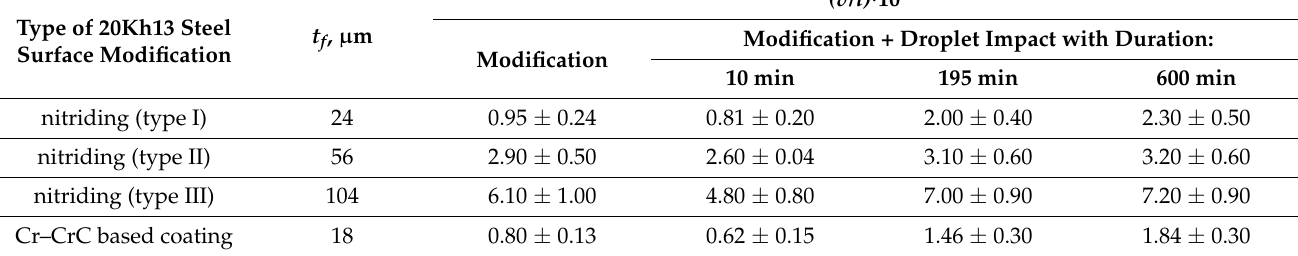
Table 3. Results of determining the average reduced normal curvature of 20Kh13 steel samples after surface modification and combined effect of surface modification and droplet impact for different durations at S imp = 250 m/s, d k = 150 µ